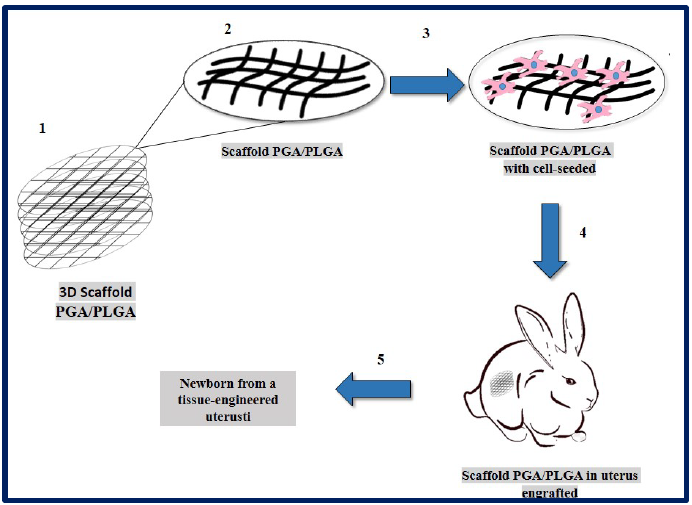
Figure 19. PGA/PLGA scaffold fabrication and in vivo implantation to tissue-engineered uterus. (1) PGA/PLGA scaffold macroscopic image. (2) PGA/PLGA scaffold details that shows its microstructure. (3) Scaffold SEM image with cell-seeded before implantation. (4) Scaffold engrafted to uterus tissue in a rabbit model. (5) Fetus was obtained then tissue-engineered uterus. Adapted from bibliography [183].